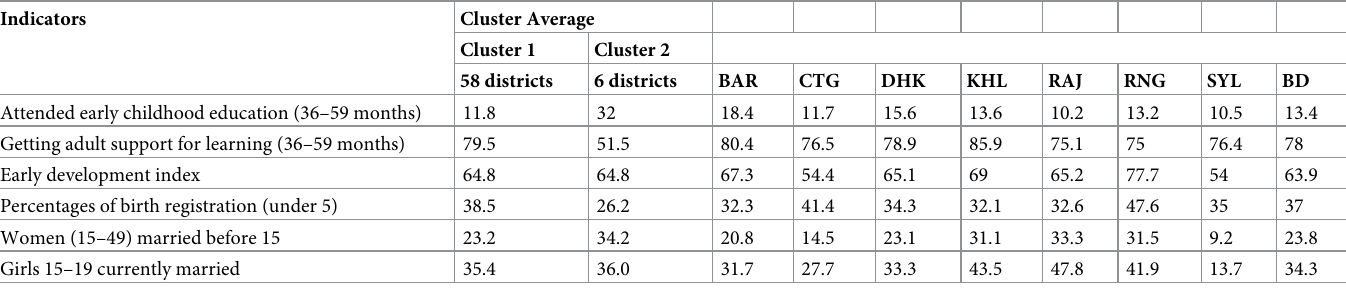
Table 4 and Fig 5 represent clusters and cluster averages for reproductive health indicators. Districts in cluster 2 (22 districts) had higher TFR per thousand women compared to the national rate (2.6 vs 2.3) whereas the other 42 districts had lower TFR (2.1). Most noticeably, districts in cluster 2 had much lower antenatal care coverage (at least once by skilled health professional) (43.4% vs 58.7% nationally), lower percentage of skilled attendant at delivery (26% vs 43.5% nationally), nearly half on institutional delivery (16.1% vs 31% nationally). However, these districts had much lower cesarean delivery compared to national figures (9.1% vs 19.1% nationally). Mass media and HIV/AIDS awareness indicators are represented in S3 and S4 Tables and S3 and S4 Figs. Cluster-2 with 5 districts were well above the national averages on all the media awareness indicators where these five districts have nearly twice as much (12.4% vs 6.1% nationally) women aged 15–24 who used computer during last 12 months (S3 Table). Three